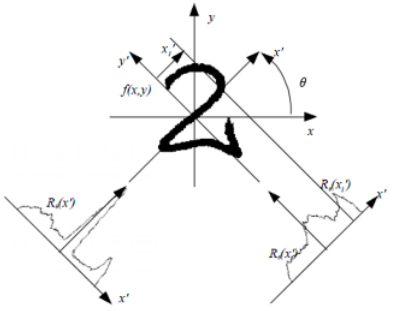
Figure 3. Radon coefficients in two different angles of projections (Miciak, 2010).